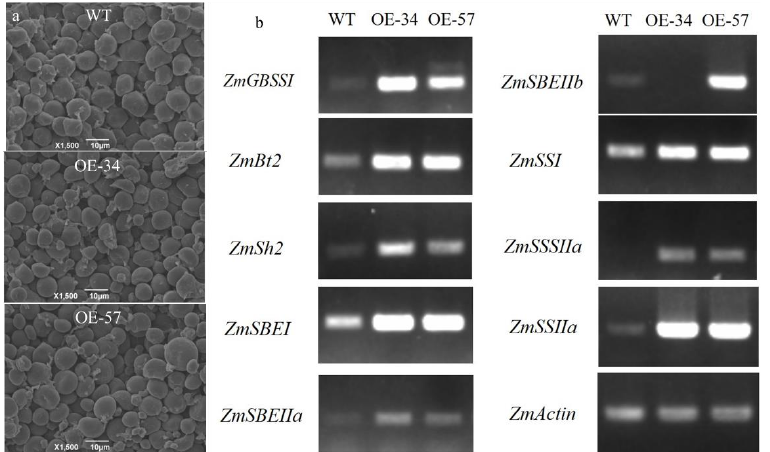
Figure 4. Morphology of starch granules ( a ) and expression of genes related to the starch synthesis pathway in mature kernels of T 3 -generation trans-GS5 maize ( b ). pathway in mature kernels of T 3 -generation trans-GS5 maize ( b Four key classes of enzymes, namely ADP-glucose pyrophosphorylase (AGPase), starch synthase (SS), starch branching enzyme (SBE), and debranching enzyme (DBE),